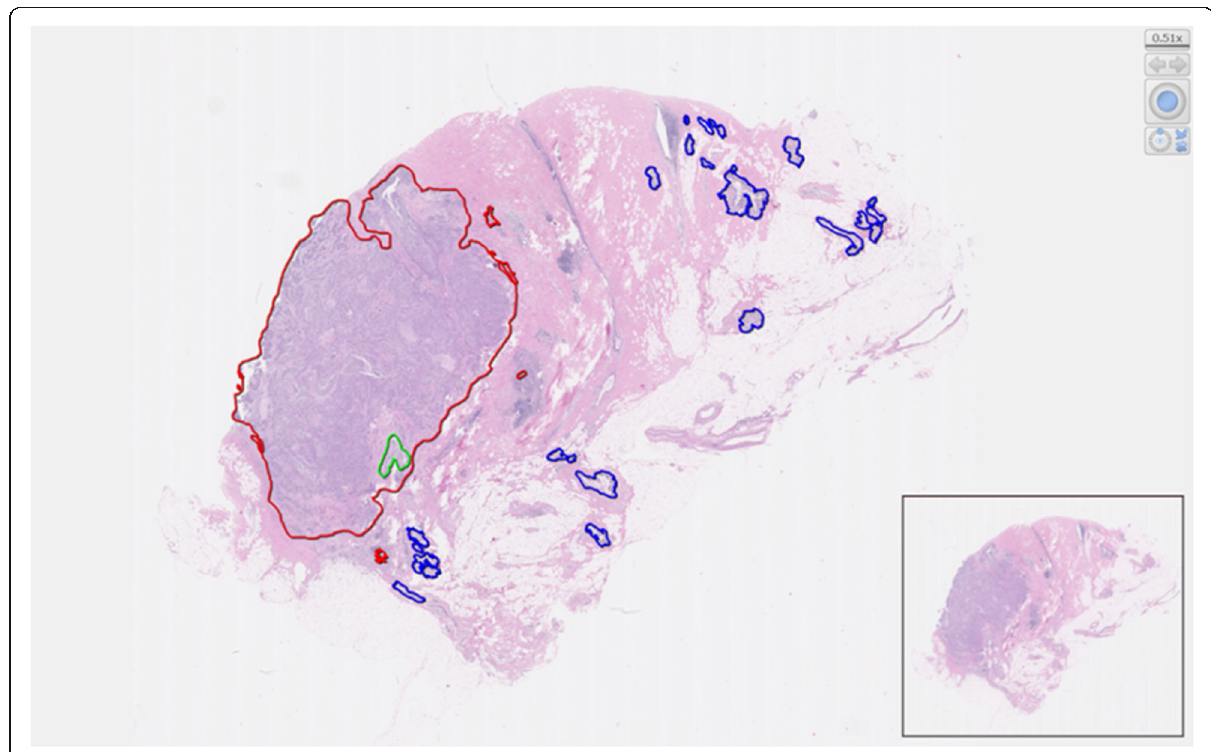
Fig. 2 Comparative pathological analysis of breast tissue regions. Regions related to breast IDC (red), ductal carcinoma in situ (DCIS) (green), and normal breast tissue (blue) are